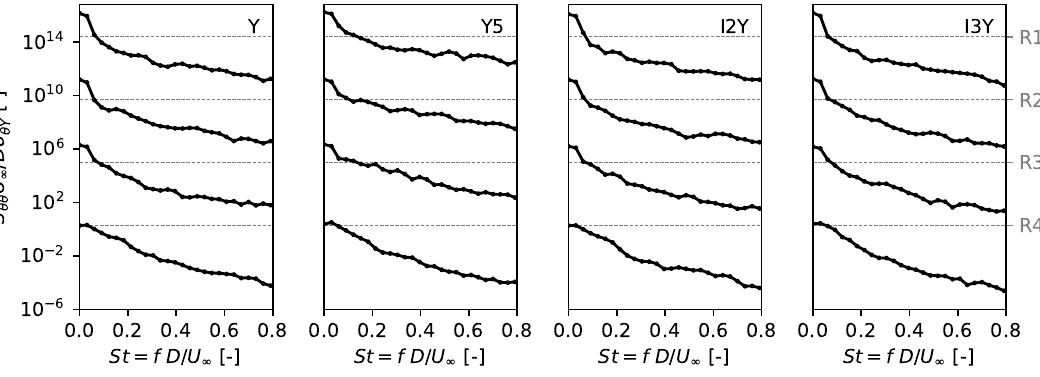
Figure 15. Row-averaged yaw angle power spectral densities S θθ as a function of Strouhal number St = f D / U ∞ . Spectra of different rows are shifted vertically for clarity. Horizontal dashed lines indicate identical reference values for each row. Spectra are non-dimensionalized using σ 2 variance of the first row yaw angles in case